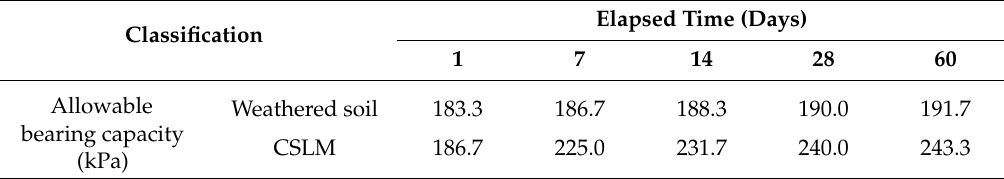
Table 8. Allowable bearing capacity of weathered soil and